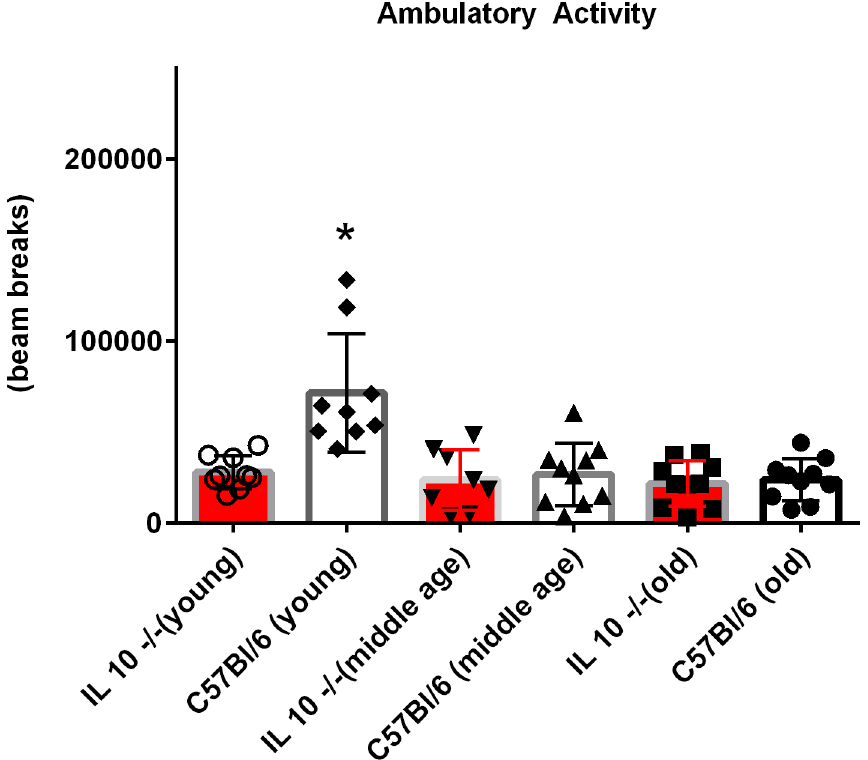
Fig 2. Ambulatory activity measuredduring indirect calorimetry using an infrared beam grid & sensors. This measurement quantifiesmotor movement whilethe subject wandersabout the chamber.